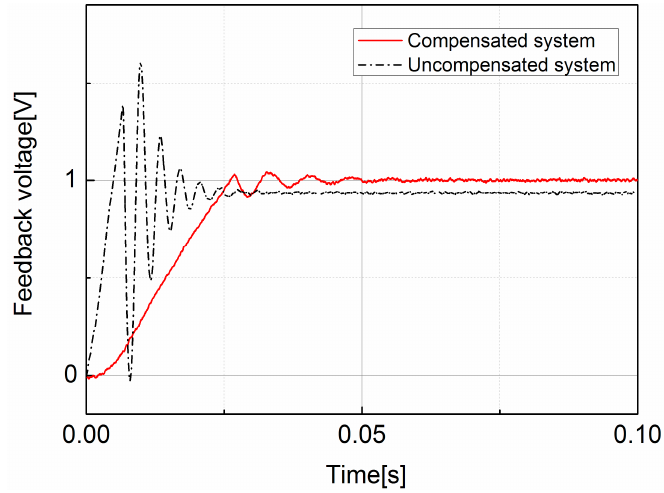
Figure 8. Time response to a step input for the uncompensated feedback control and the compensated feedback control. Table 1. The performance of two feedback control systems.